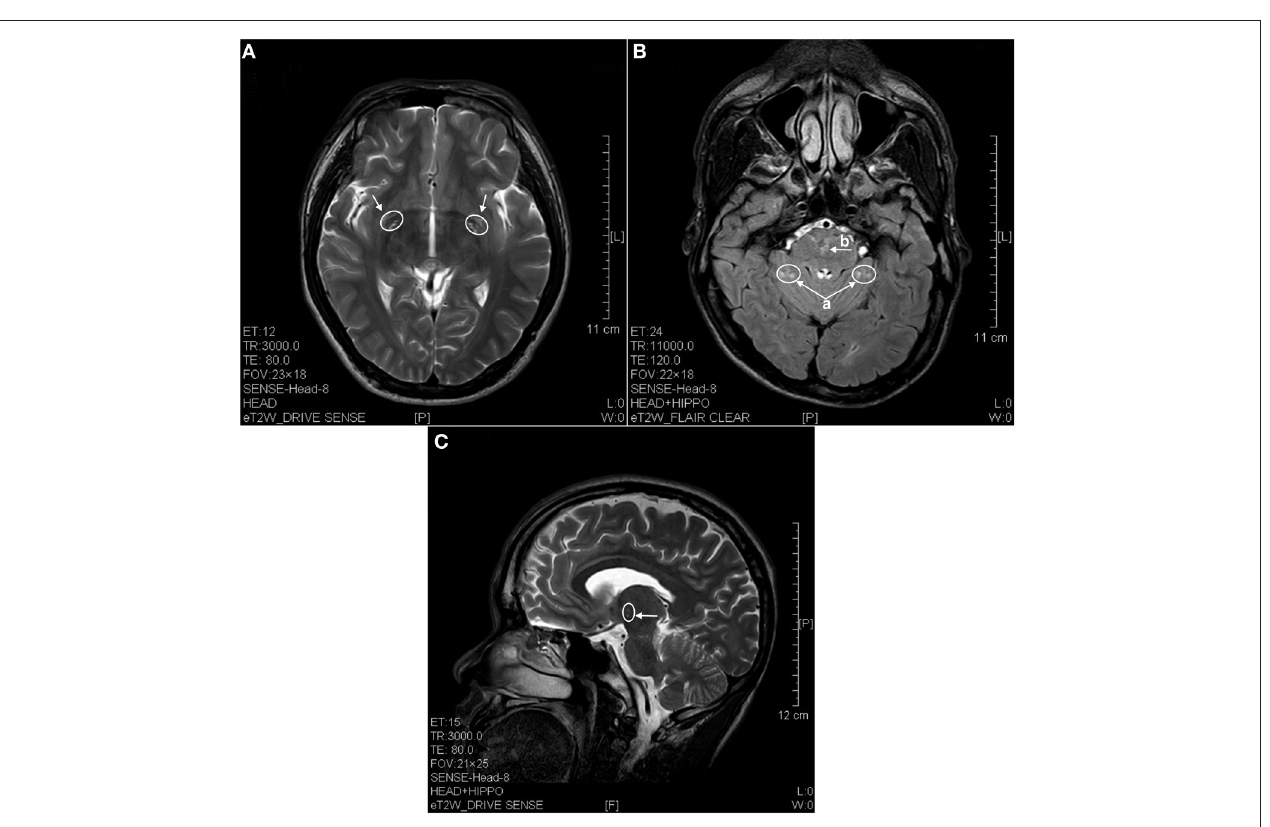
horizontal section showing hyperintense degeneration in cerebellum (a) and in pons (b). (C) T2 image of a sagittal section showing degeneration spots in diencephalon